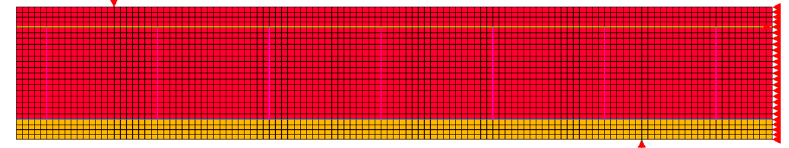
Figure 3. Mesh size and finite element model of one half of the beam.